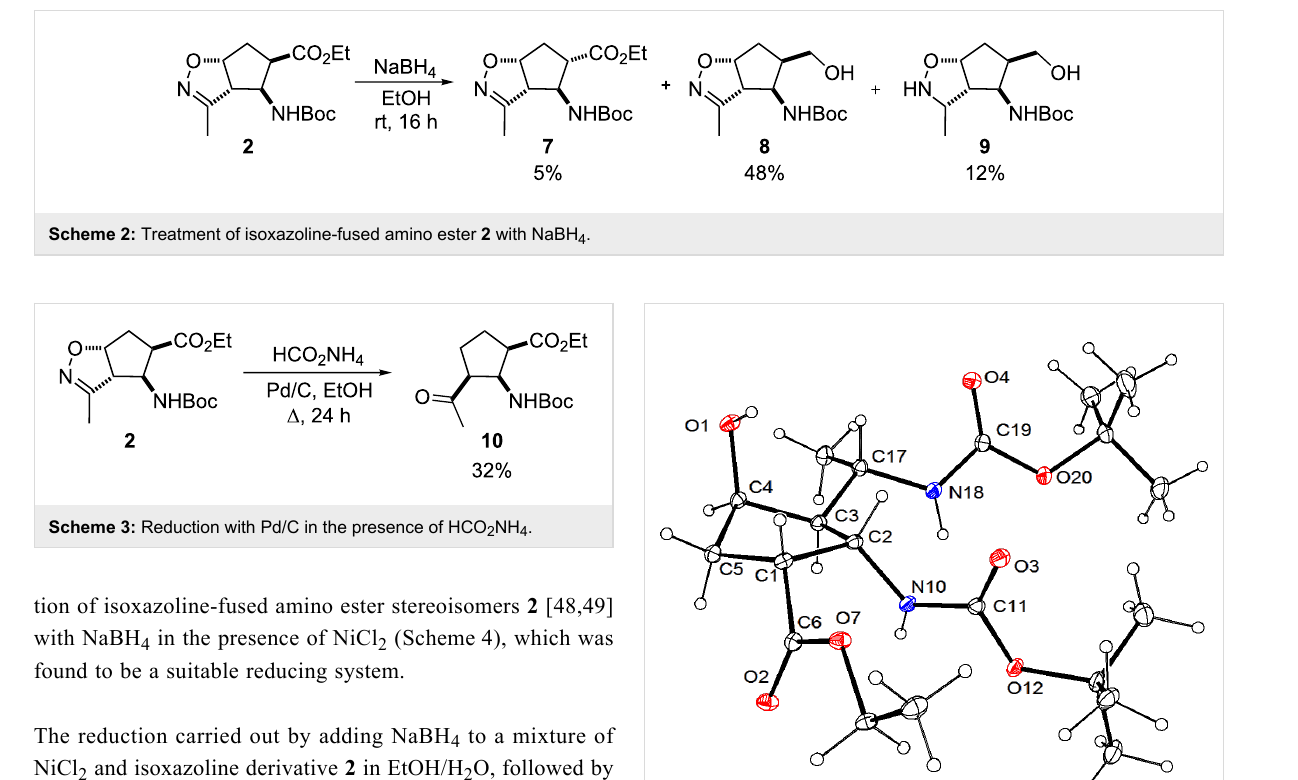
Figure 2: ORTEP diagram of 12 showing the atomic labeling scheme. The thermal ellipsoids are drawn at the 20% probability level.